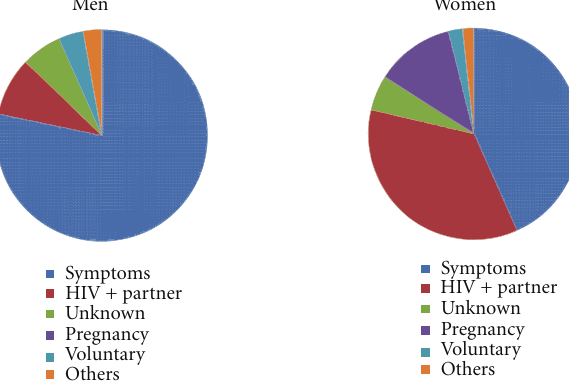
Figure 1: Reasons for HIV diagnosis in women and men.